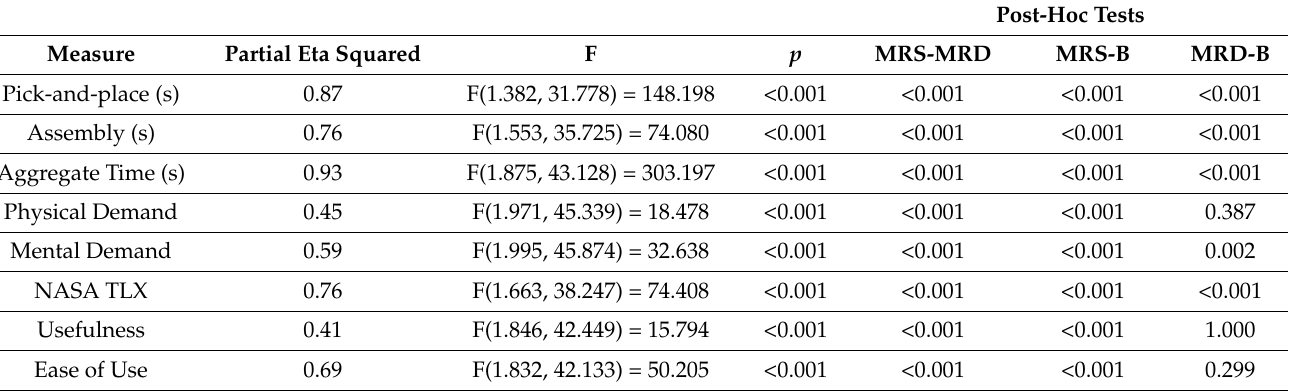
Table 1. One-way ANOVA statistics for all measures. B, MRD, and MRS denote Baseline, MR SpaceMouse, and MR subspace, respectively.